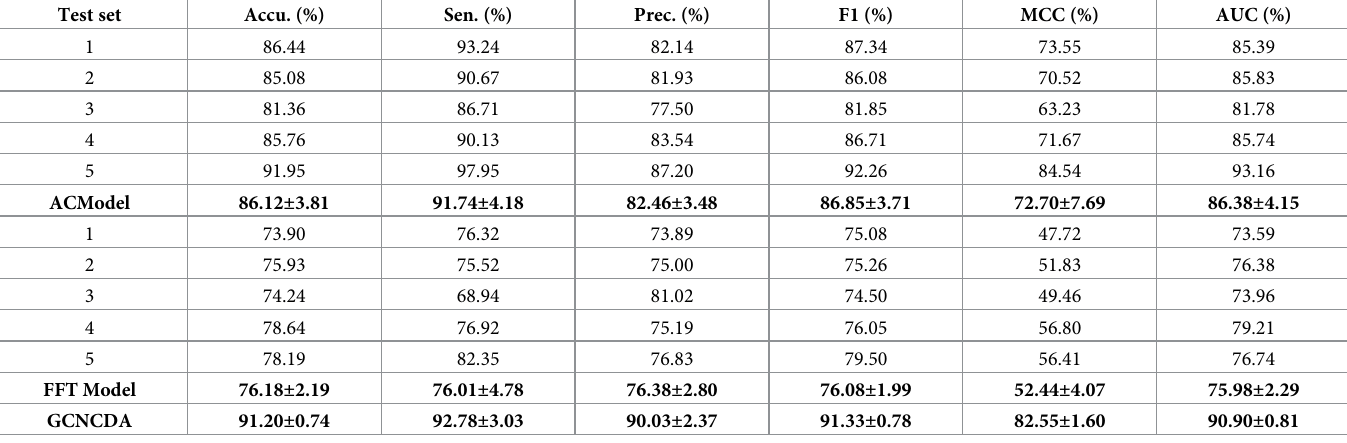
Table 3. Results of 5-fold CV generated by AC model and FFT model on circR2Disease